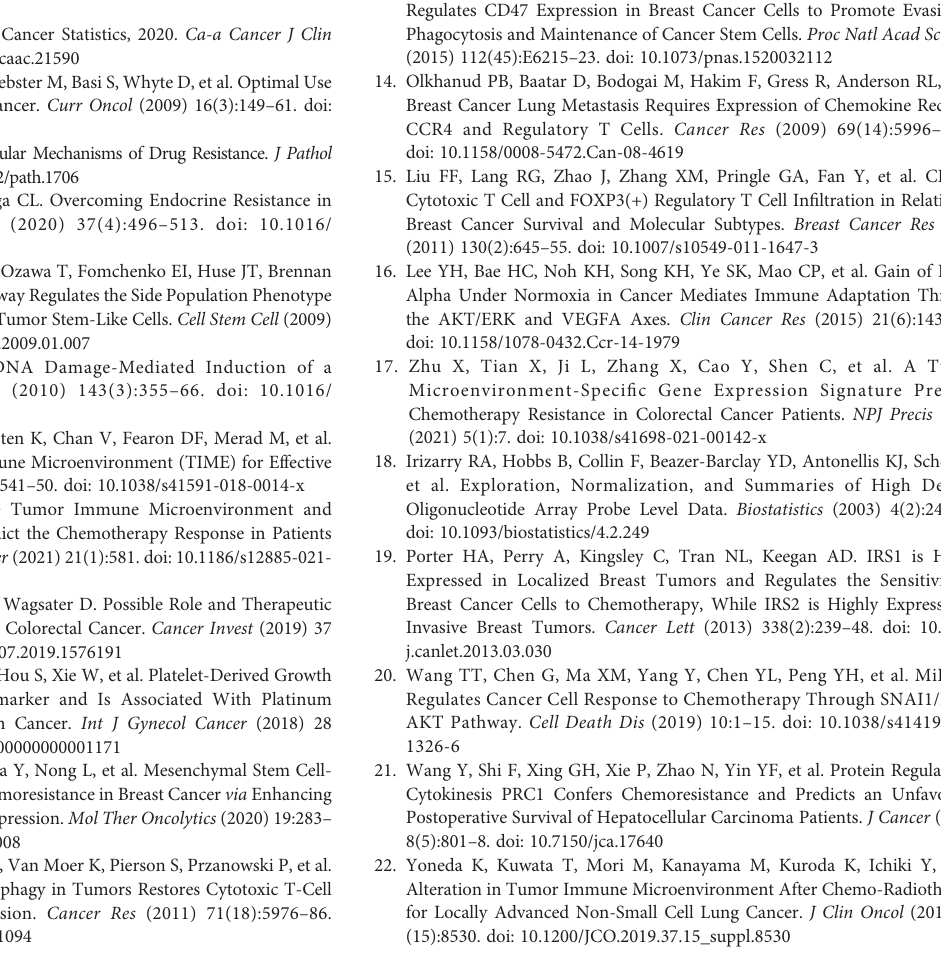
Supplementary Figure 1 | The work fl ow of our